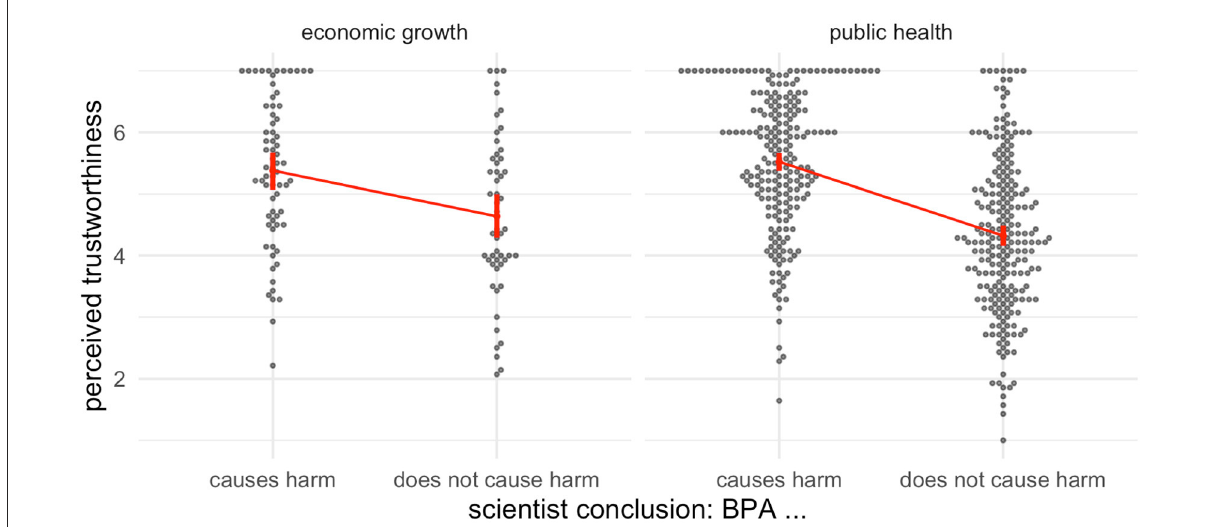
FIGURE4 Data, group means, and 95% confidence intervals for H5-consumer, interaction of consumer risk sensitivity and participant values. Panels correspond to participant values.